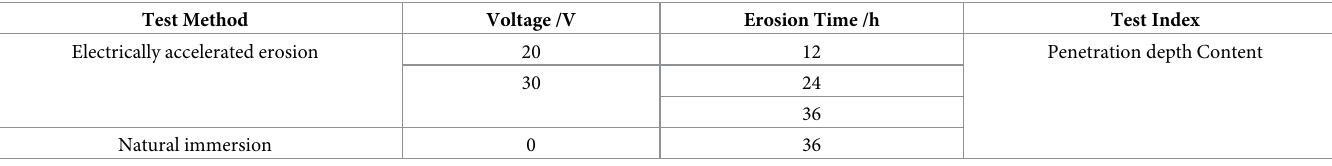
Table 3. Experimental